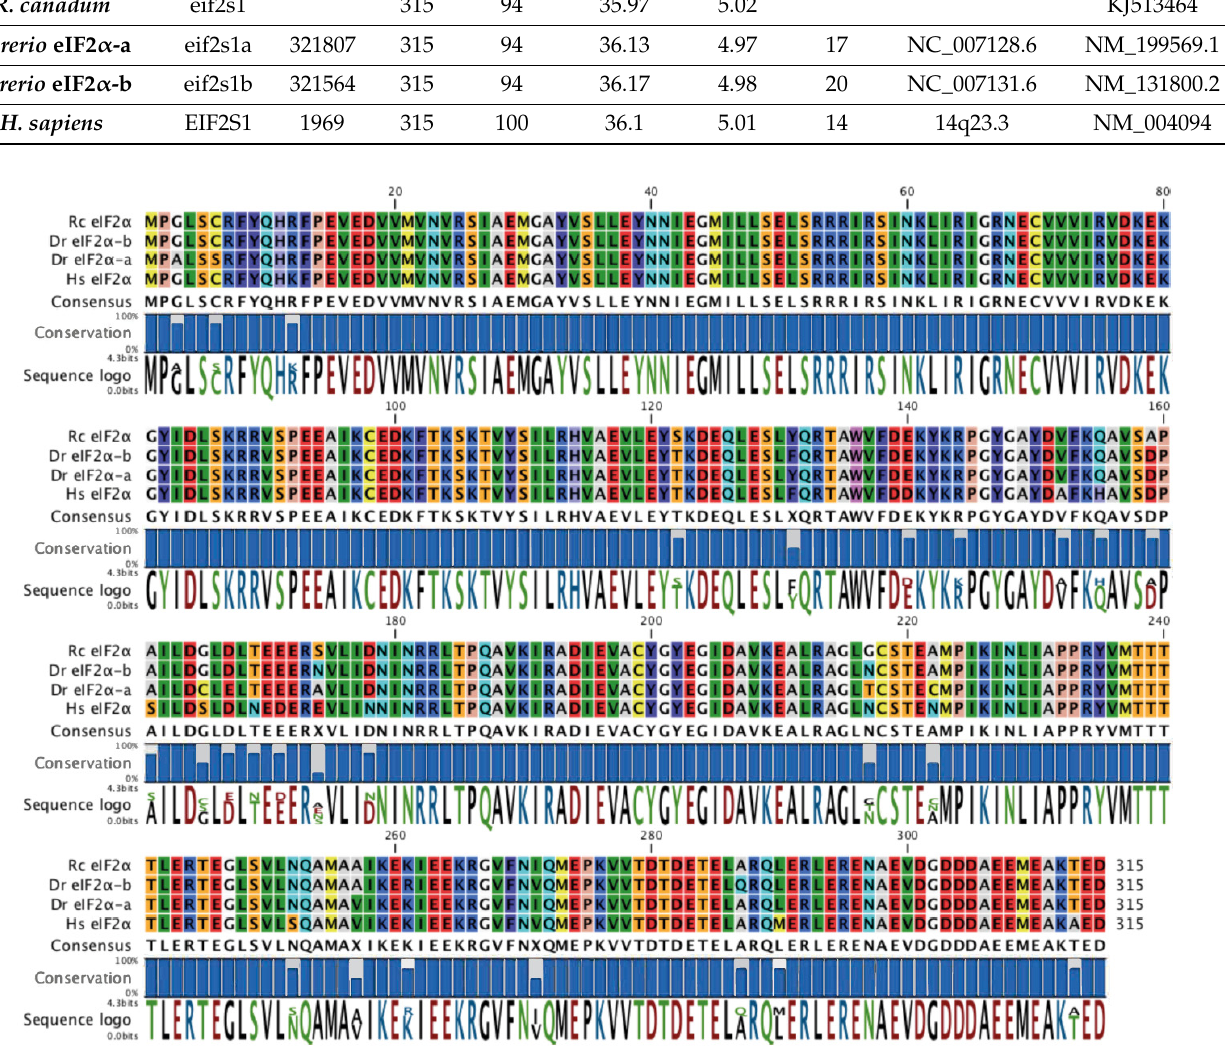
Figure 3. Multiple alignment of eIF2 α from cobia, zebrafish, and human eIF2 α from cobia, Rachycentrum canadum, compared with zebrafish eIF2 α s and human.